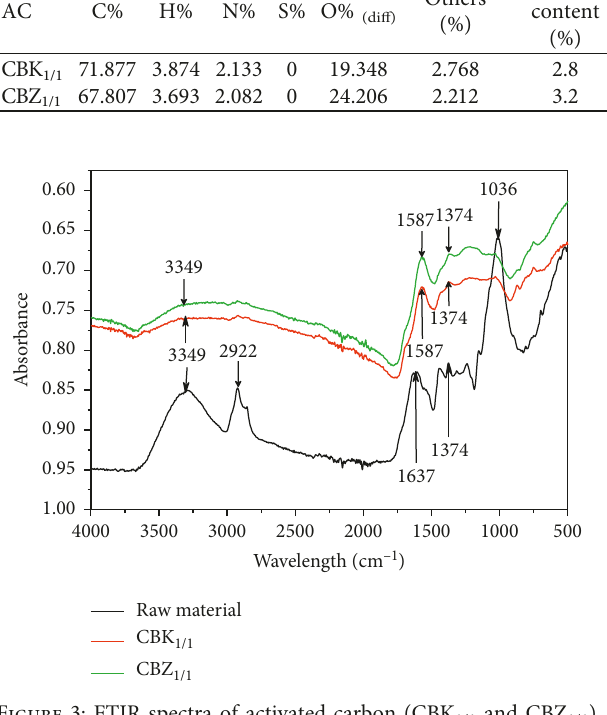
1/1 and CBZ 1/1 .